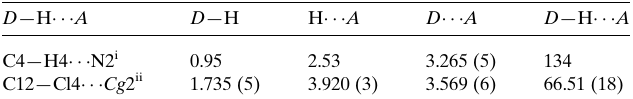
Table 1 Hydrogen-bond geometry (A˚ , (cid:3) ).